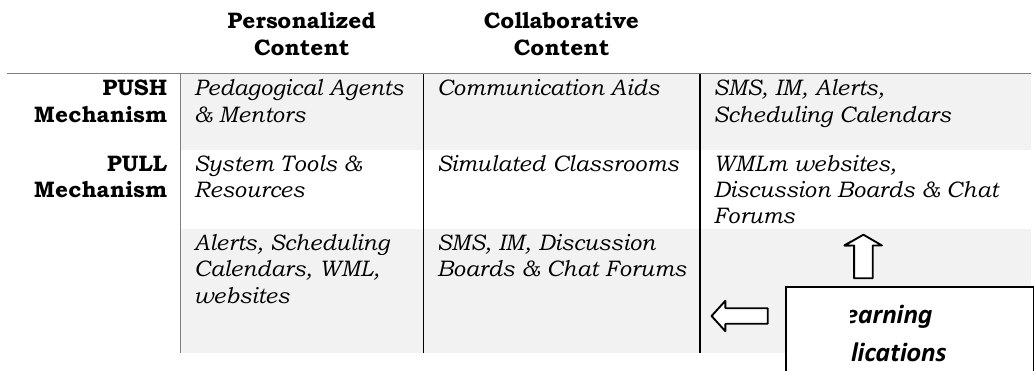
Figure 2. Motiwalla (2007) Mobile Learning Framework